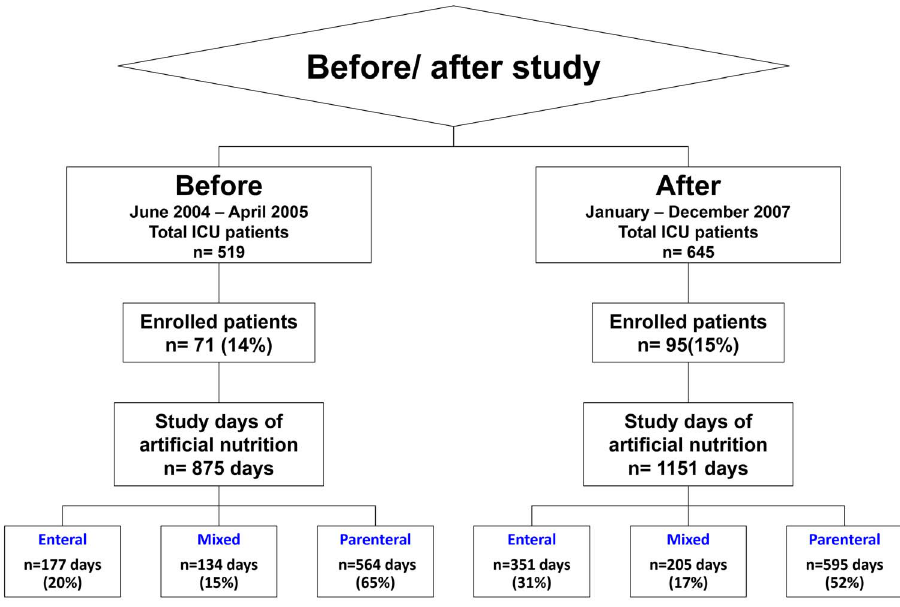
Figure 2. Study flow chart.